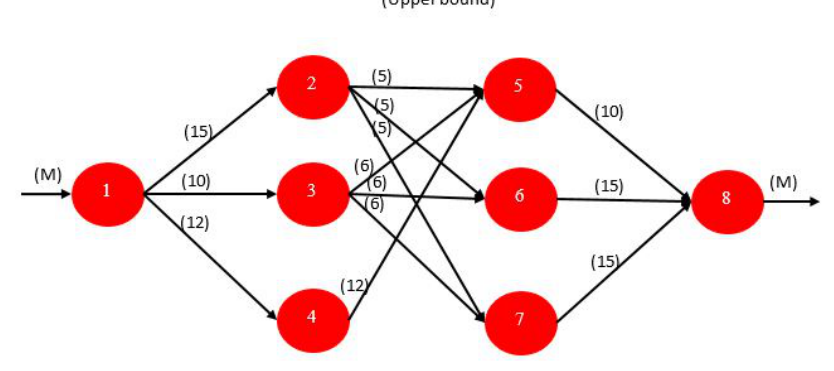
Figure 7. NFP model of a maximum flow problem.